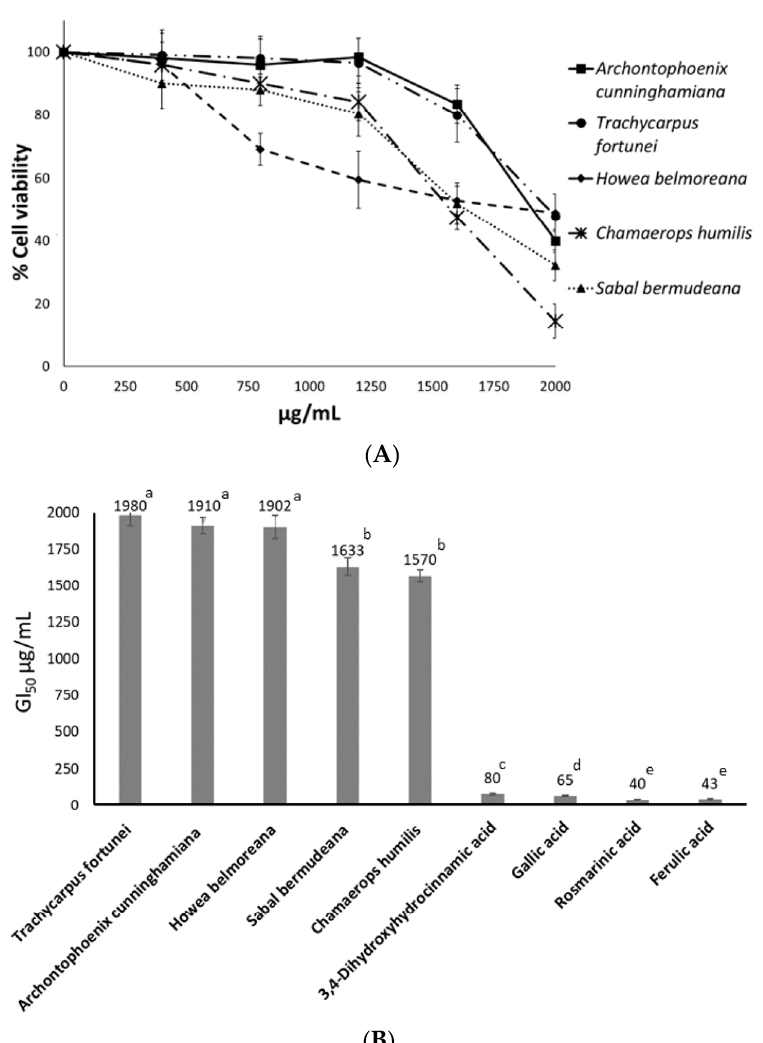
Figure 1. MTT assay. ( A ): Concentration-response plot for HT-29 cells after exposure to five Arecaceae seed extracts for 72 h. ( B ): GI 50 after HT-29 cell exposure for 72 h to five seed extracts and to 3,4-dihydroxyhydrocinnamic, gallic, rosmarinic, and ferulic acids. Data represent the mean of three complete independent experiments ± SD (error bars). Above the bars, means followed by different letters are significantly different at p < 0.05.